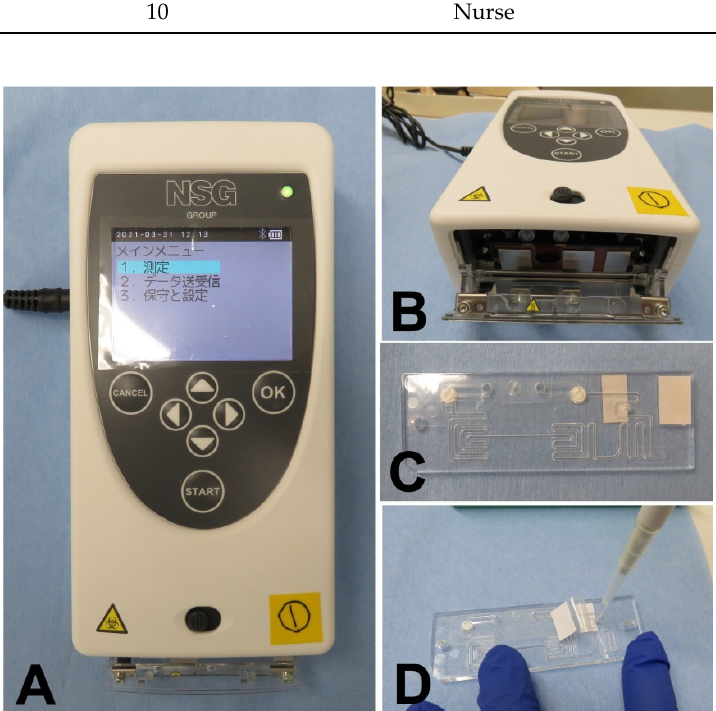
Figure 1. PCR1100 device body and flow path chip: ( A ) PCR1100 body (top). ( B ) Bottom (opening). Three heat blocks were provided. ( C ) Flow path chip. The sample moved in the flow path, the temperature was controlled by three heat blocks, and the PCR reaction proceeded. ( D ) The sample was injected into the hole of the flow path tip.